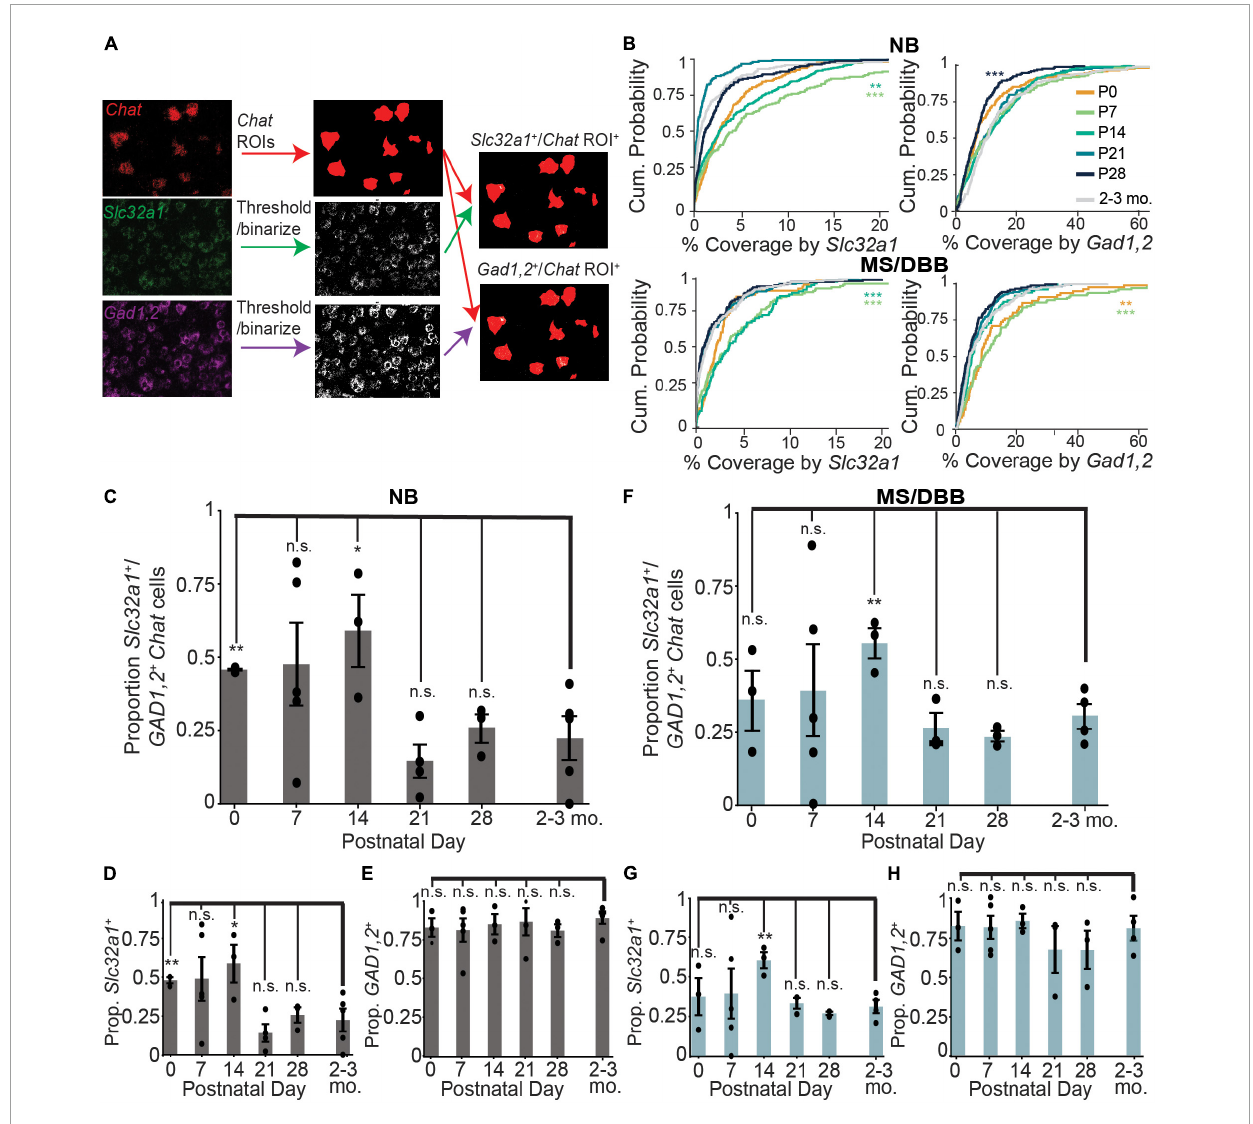
FIGURE2 Expression of Slc32a1 and Gad1,2 peak at postnatal days 7 and 14 in ChAT + neurons of the NB and MS/DBB. (A) Schematic of the imaging analysis pipeline. Raw images of ChAT fluorescence are binarized and converted to ROIs corresponding to Chat -expressing neurons. Slc32a1 and Gad1,2 signal are thresholded and binarized, and the puncta overlap with Chat ROIs (yellow) and quantified for percent coverage. (B) Cumulative distribution of Chat ROI coverage by Slc32a1 (left panels) and Gad1,2 (right panels) expression across all neurons in the NB (top row) and MS/DBB (bottom row) between P0 and P28. Asterisks indicate statistically significant differences in the distribution of ROI coverage at each developmental time point compared to cells from 2-3 month old mice (** p ≤ 0.01, *** p ≤ 0.001). (C–E) Quantification of Chat + cells in NB that are co-positive for both Slc32a1 and Gad1,2 (C) , Slc32a1 alone (D) , or Gad1,2 alone (E) . (F–H) Quantification of Chat + cells in MS/DBB that are co-positive for both Slc32a1 and Gad1,2 (F) , Slc32a1 alone (G) , or Gad1,2 alone (H) . Data from (B–H) includes between 73-319 Chat + cells from either BF or MS/DBB, from n = 3-5 mice per time point. Data are represented as mean ± s.e.m., Asterisks indicate statistically significant differences in the proportion of positive cells in each mouse compared to 2-3 month old mice (* p ≤ 0.05, ** p ≤